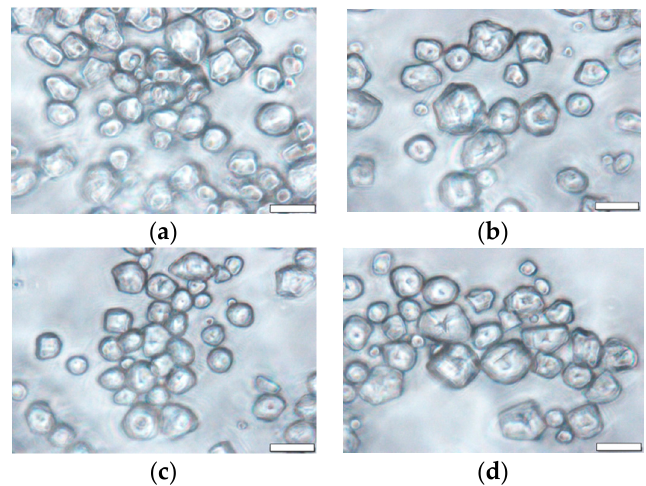
Figure 3. Micrographs of ( a ) native, ( b ) annealed, ( c ) succinylated, and ( d ) dual modified corn starch. Scale bar represents 20 µm.